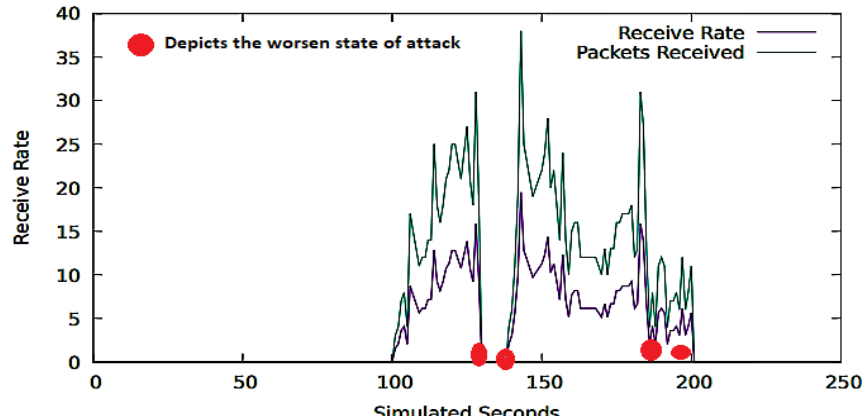
Figure 17. The stats in the network under